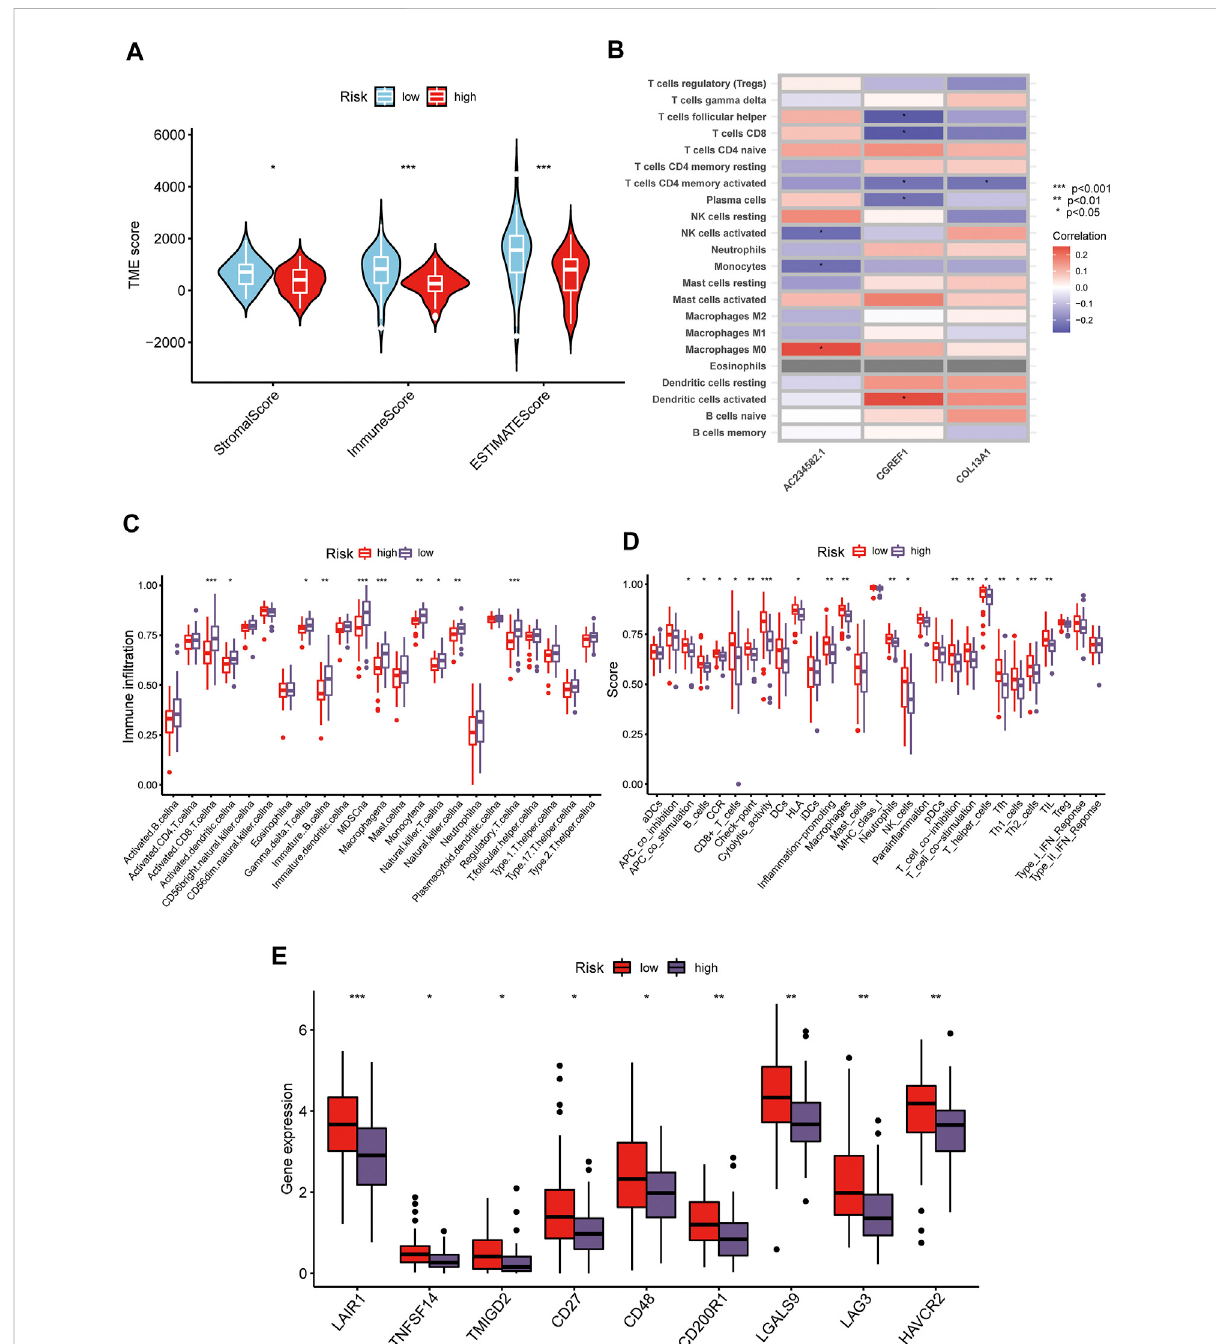
FIGURE 6 Distinct TME characteristics and mutation of OS patients according to the risk score. (A) Correlations betweenrisk score and both immuneand stromal scores. (B) Correlations between risk score and immune cells. Boxplots showed (C) abundance of 23 in fi ltrating immune cell types and (D) differences in immune scores in the two risk score groups. (E) The boxplot shows variations in the expression of CUGs between the two risk score groups. ( p < 0.05 *; p < 0.01 **; p < 0.001